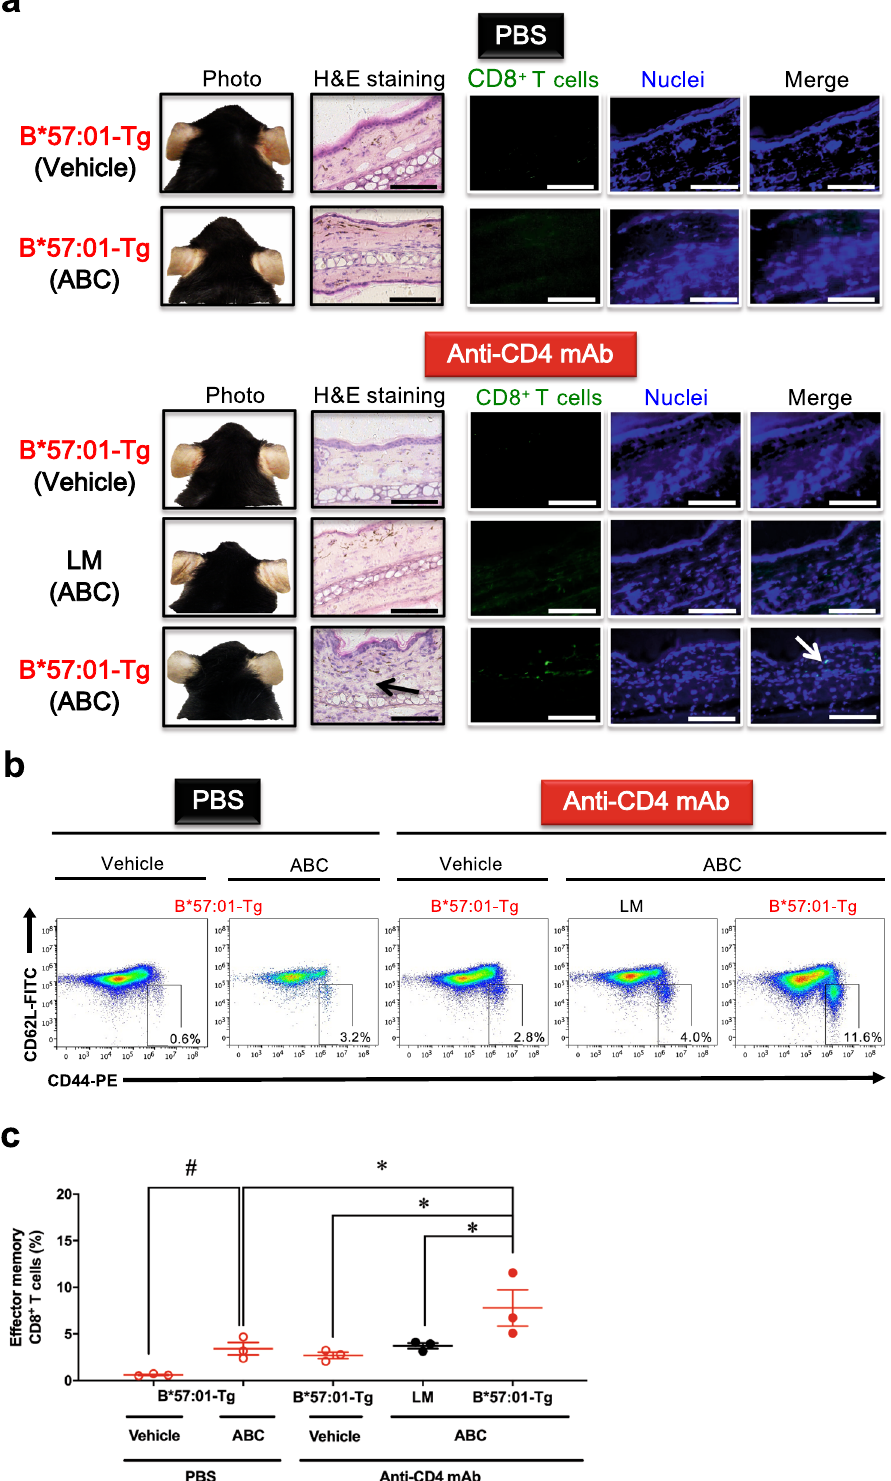
PD-1 as an AHS suppressor in CD4 + T cell-depleted B * 57:01-Tg mice. To determine whether PD-1 contributes to the immuno- suppression in the CD4 + T cell-depleted scenario, we measured PD-1 expression of effector memory CD8 + T cells in CD4 + T cell-depleted B * 57:01-Tg mice (Fig. 2). Upregulated PD-1 expression was observed on day 7 in both auricular LNs and spleen-derived effector memory CD8 + T cells of ABC-fed